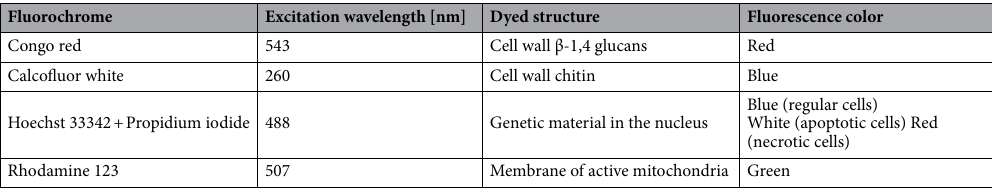
Table 1. Fluorescent dyes and their